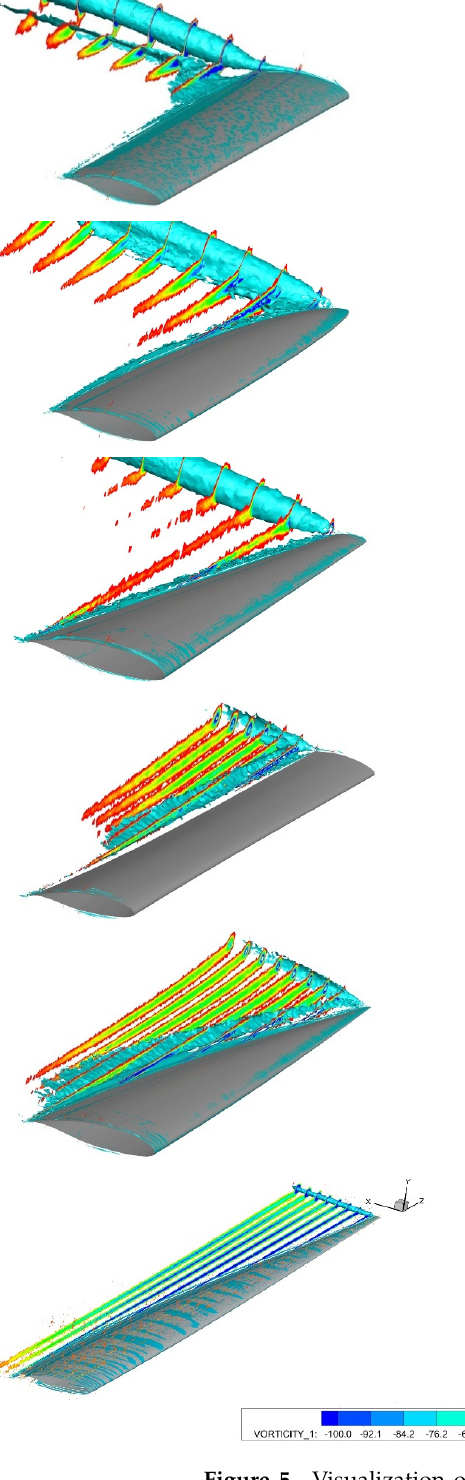
Figure 5. Visualization of the fluid flow over the wing, cross-section vorticity and Iso-surface Q-criterion ( left side ); polar diagram—aerodynamic coefficient is related to the reference area ( right side ). From top to bottom: ( a ) rectangular, ( b ) elliptic, ( c ) trapezoidal, ( d ) BSLD-TW, (e) BSLD-UTW and ( f ) FREE-OPT wing.